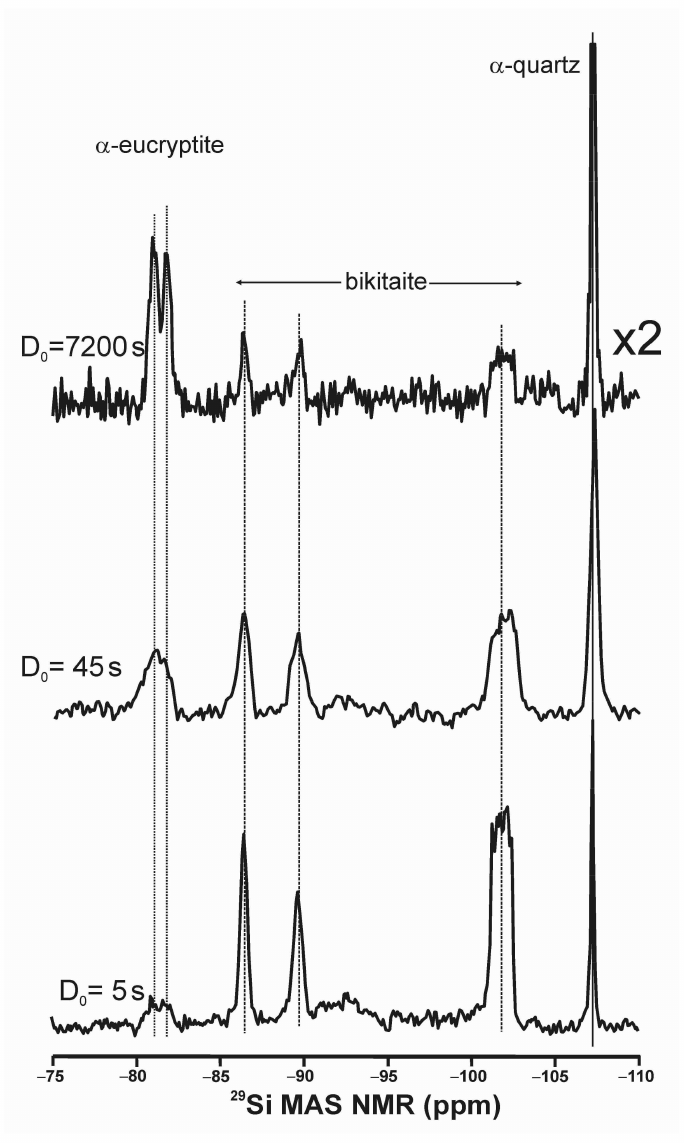
Figure 12. The 29 Si MAS NMR spectra of specimen Bikita (Figure A3) is formed by a mixture of α -eucryitite with signals at − 81.1 and − 81.9 ppm; bikitaite with resonances at − 86.5, − 89.7, and a broad centered signal at − 101.9 ppm (with twice the area of the other two); α -quartz at − 107.3 ppm, in three different spectra recorded with recycling times (D 0 values in seconds) of 5 s and 7200 s at 9.4 T; and also of 45 s at 7.05 T. For the spectra using D 0 of 5 s and 45 s, pulses of 0.5 µ s (10 ◦ ) were used; whereas for the spectrum with D 0 of 7200 s, pulses of 30 ◦ were